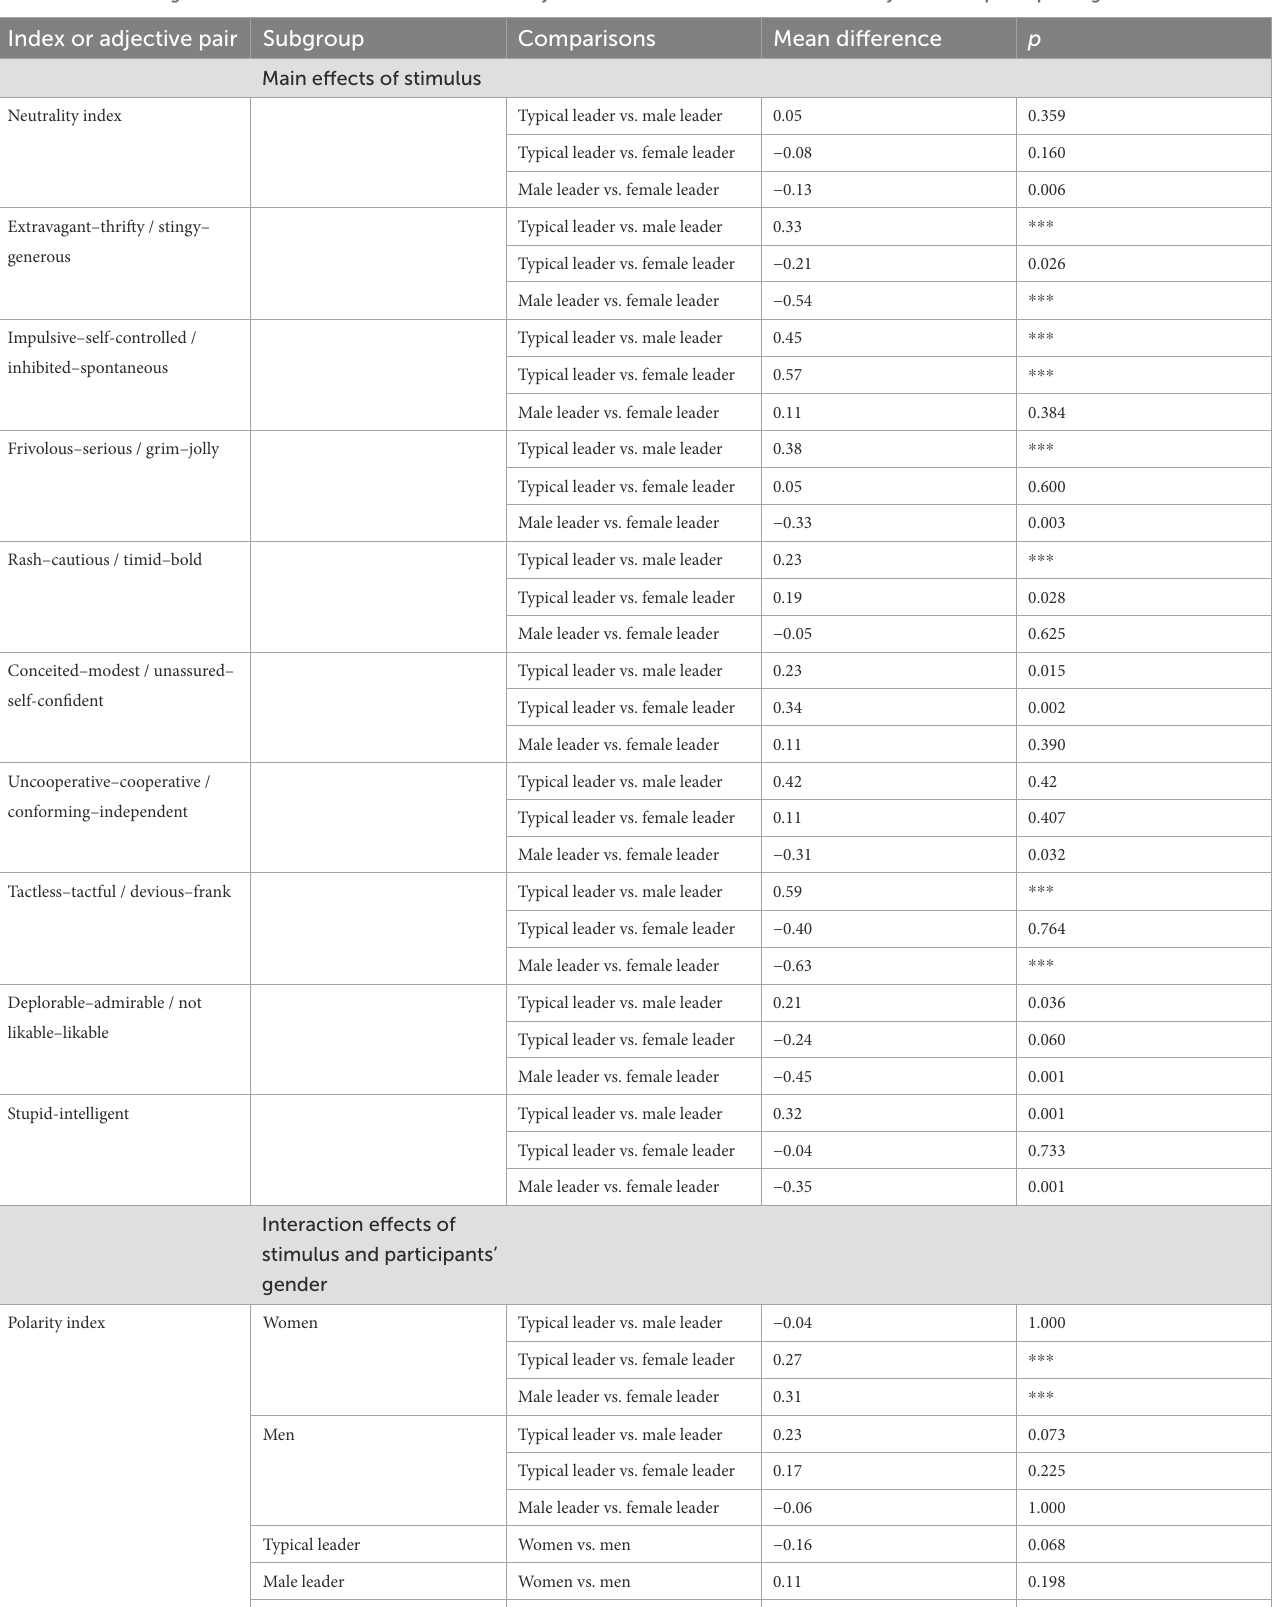
TABLE 4 Mean differences and p -values of pairwise comparisons of indices and adjective pairs’ significant main effects of the independent within-subjects factor stimulus and significant interaction effects of the within-subjects factor stimulus and the between-subjects factor participants’